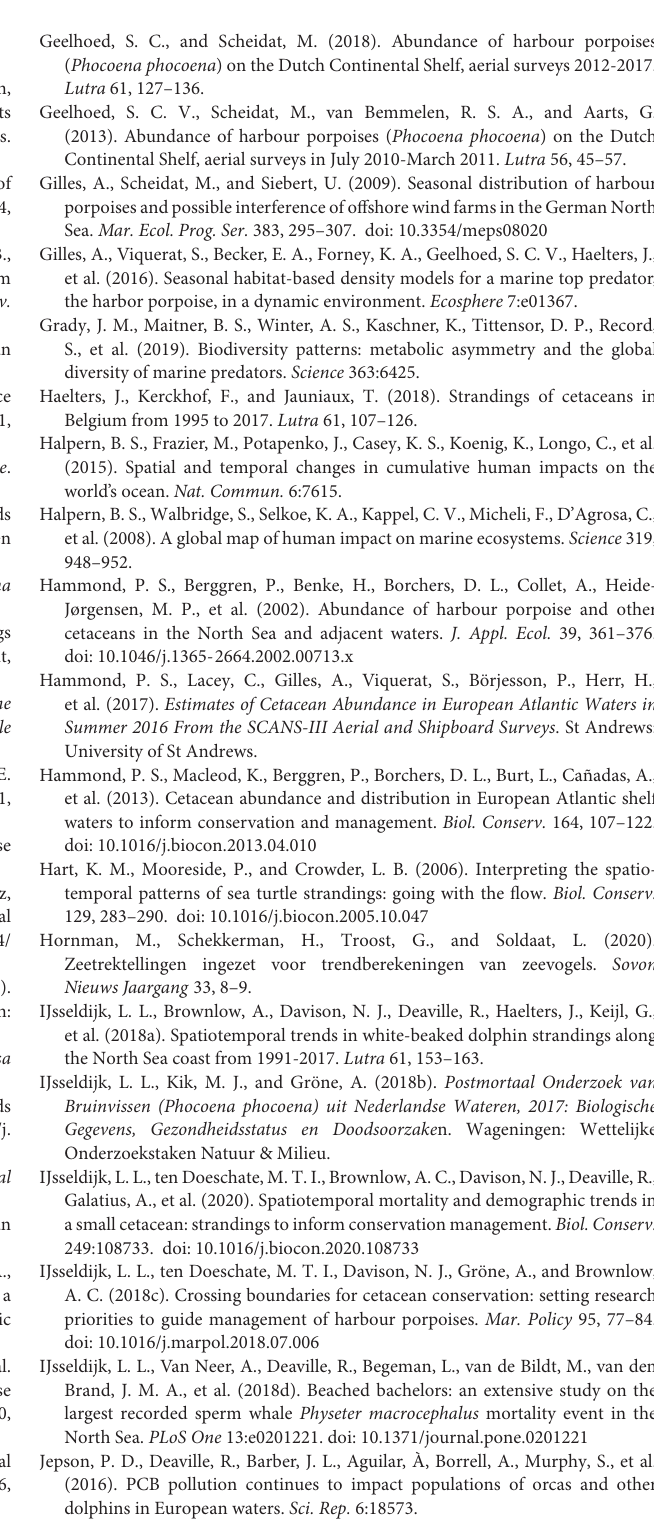
Supplementary Data 1 | Output of model fitted to the coastal sightings of porpoises to correct for the effect of weather related environmental